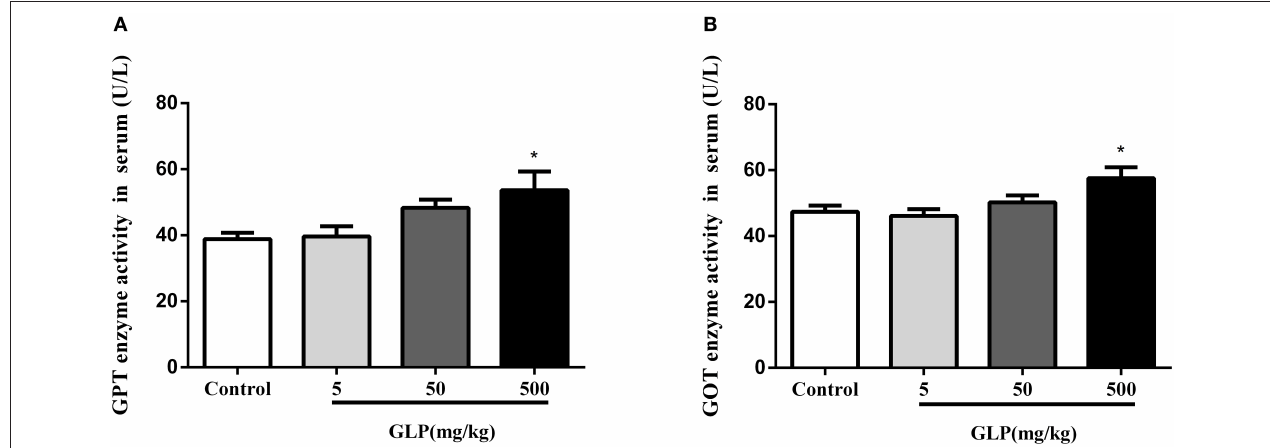
FIGURE 2 | Effect of GLP treatment on GPT (A) and GOT (B) enzyme activities in the serum. Data shown are mean ± SEM of eight animals in each group. Compared to control; * p < 0.05.